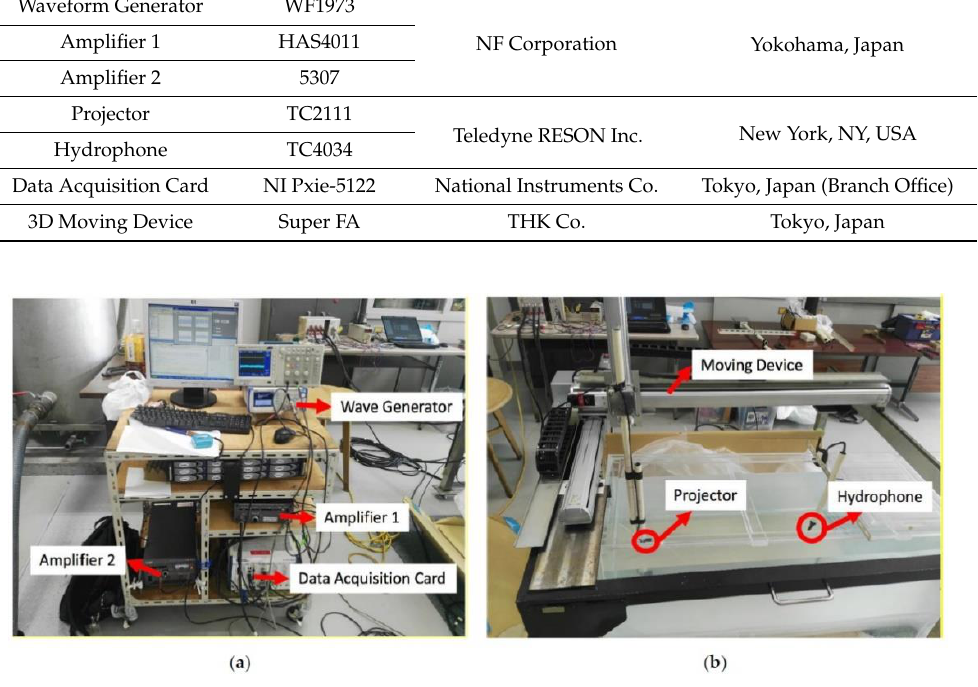
Figure 4. Experiment system: ( a ) signal generator and receiver, including wave generator, two amplifiers and data acquisition card; ( b ) moving system, including moving device, projector and hydrophone.